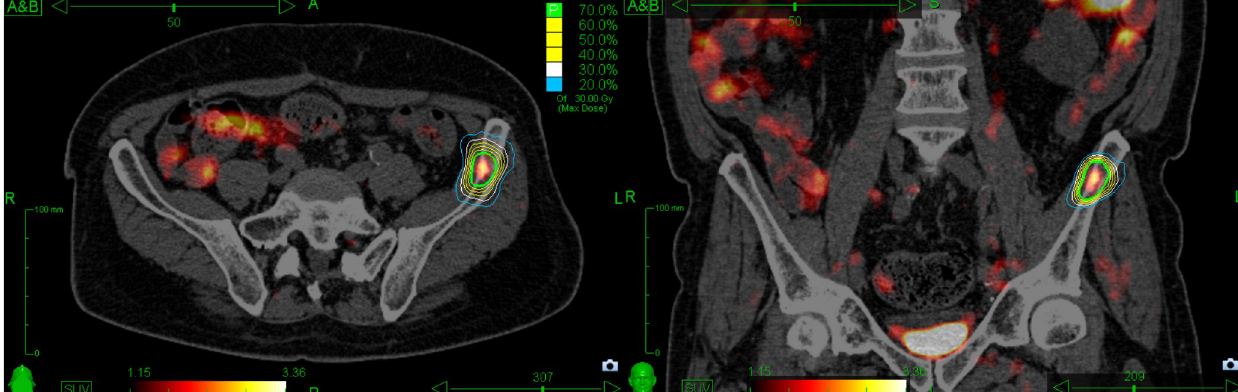
Fig 1. PSMA-PET/CT based radiotherapy treatment plan of CyberKnife treatment system for bone metastasis located in the left ilium.